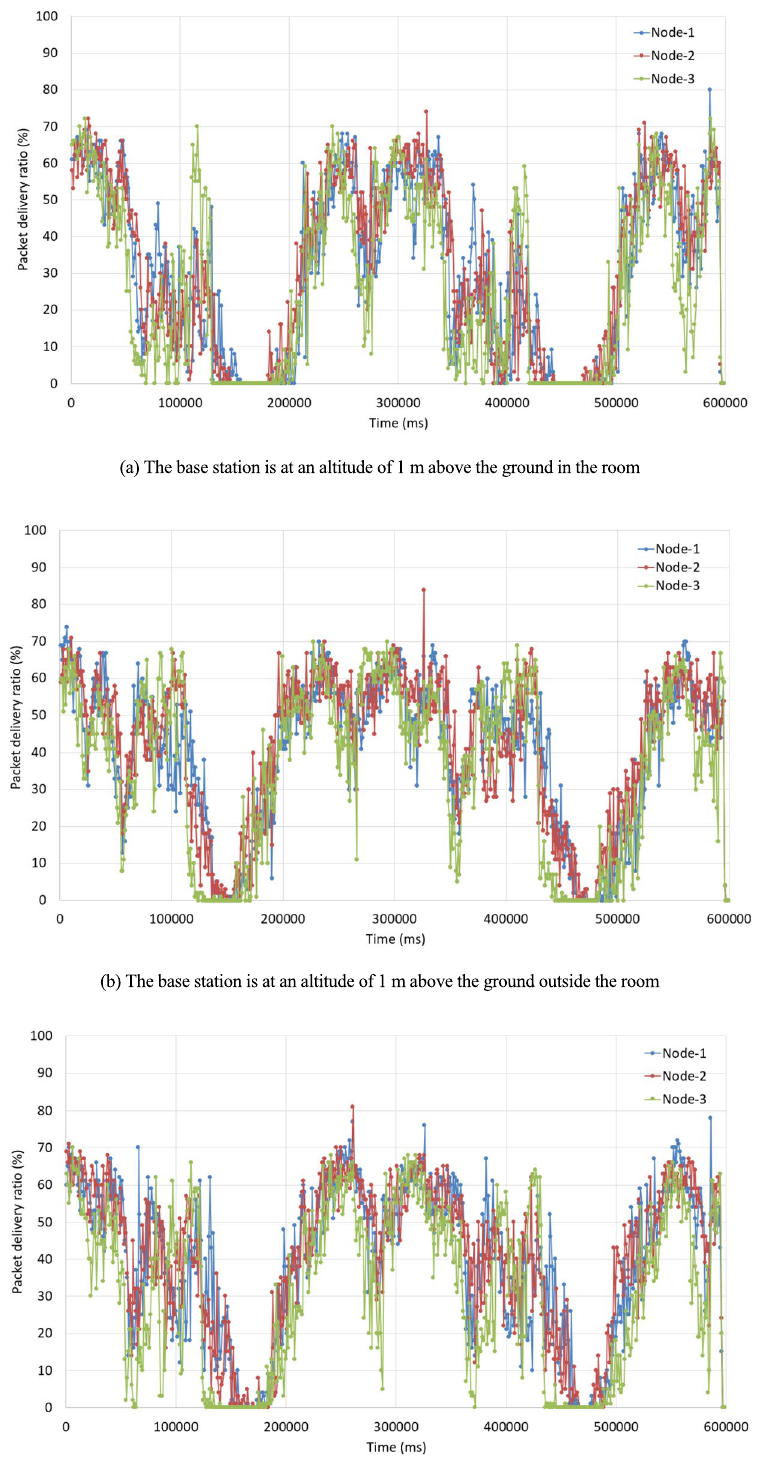
Fig. 15 The PDR versus time index for the test case #5. a The base station is at an altitude of 1 m above the ground in the room. b The base station is at an altitude of 1 m above the ground outside the room. c The base station is at an altitude of 2.5 m above the ground outside the